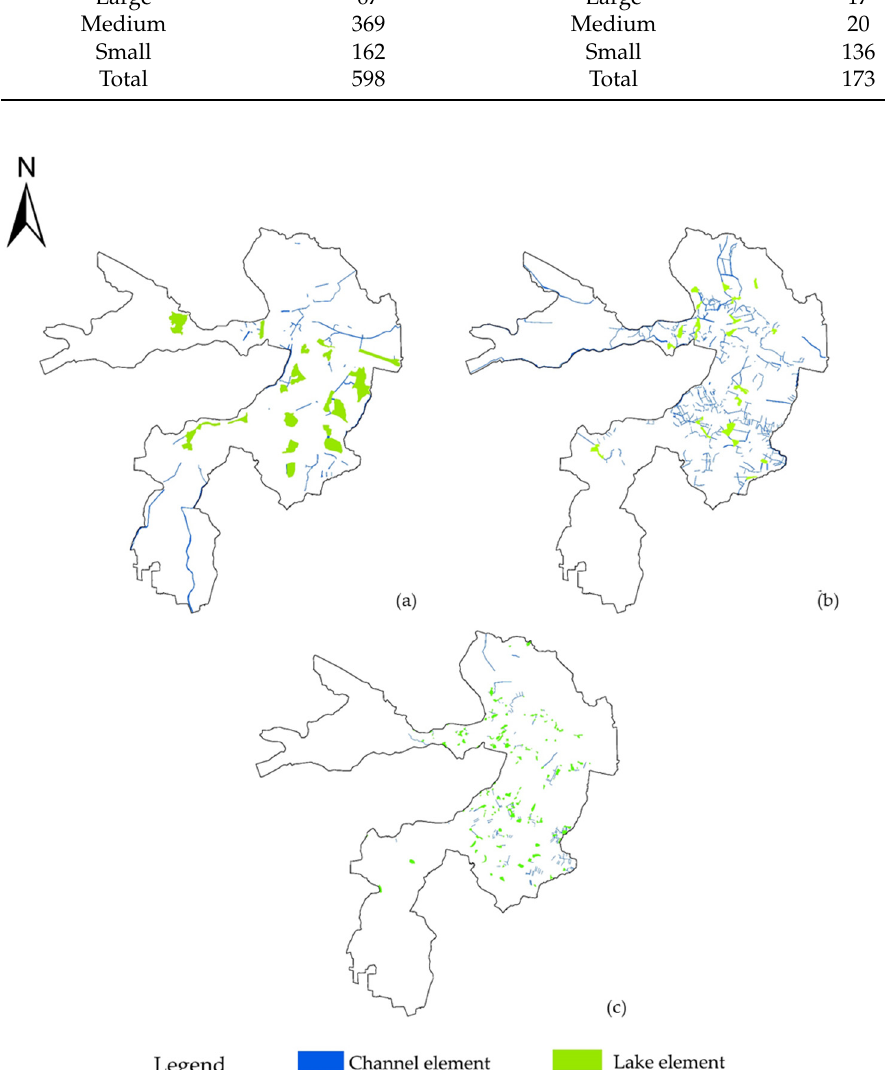
Figure 6. Grading results for the channel and lake elements: ( a ) large, ( b ) medium, and ( c ) small elements based on the criteria in Tables 7 and 8.